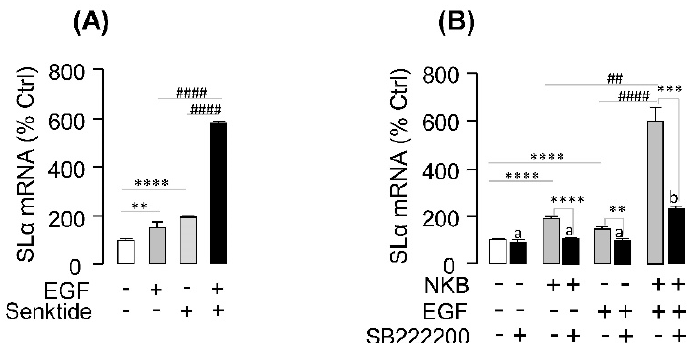
Figure 6. Synergistic effects of EGF with NK3R agonist and antagonist. ( A ) EGF (10 nM) synergizes with NK3R agonist senktide (1 µ M) to stimulate SL α mRNA expression in grass carp pituitary cells. ( B ) Effects of NK3R antagonist SB222200 on EGF, NKB or EGF + NKB-induced SL α mRNA